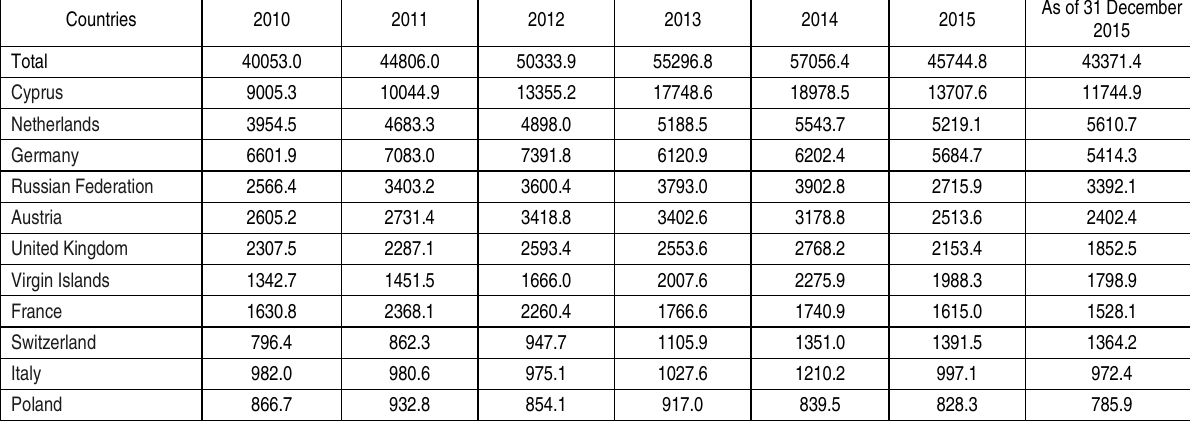
Table 2. Foreign direct investments (joint-stock capital) of the world’s countries into the Ukrainian economy (volumes of direct investments as of January 1), million US dollars